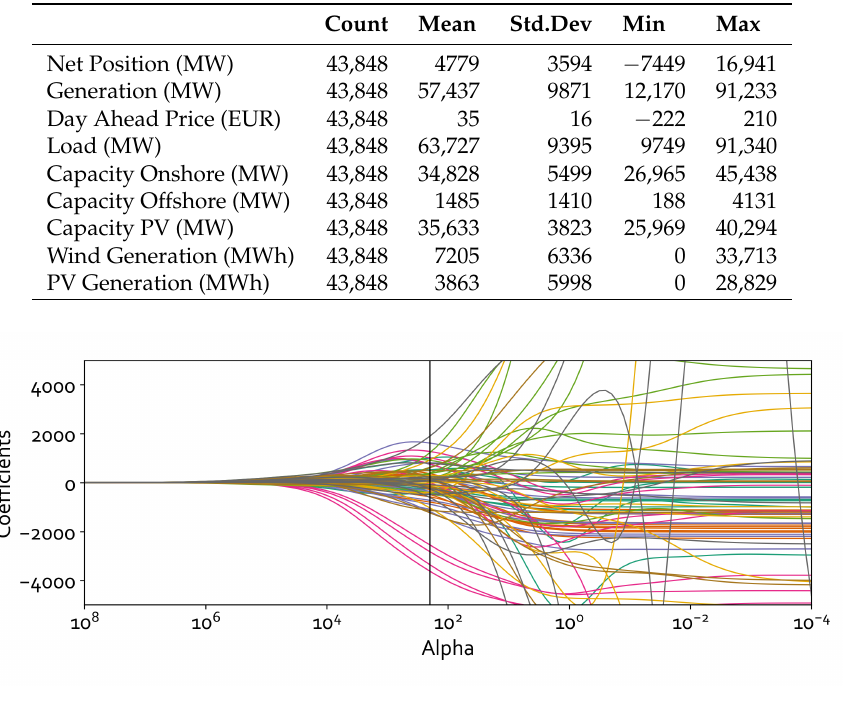
Figure A1. The rendered coefficients in relation to different levels of α , from large to small (Vertical line corresponds to the chosen value of α = 200). Source: own diagram. Table A2. Variation Inflation Factors of all explanatory